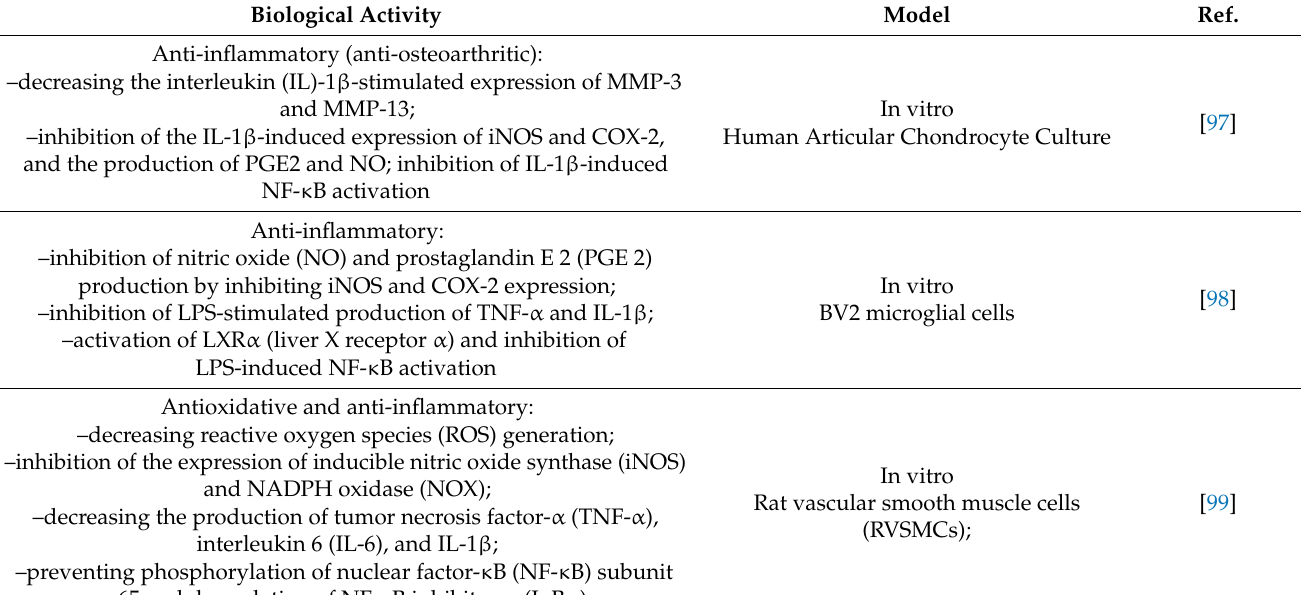
Table 2. Pharmacological activity of tormentic